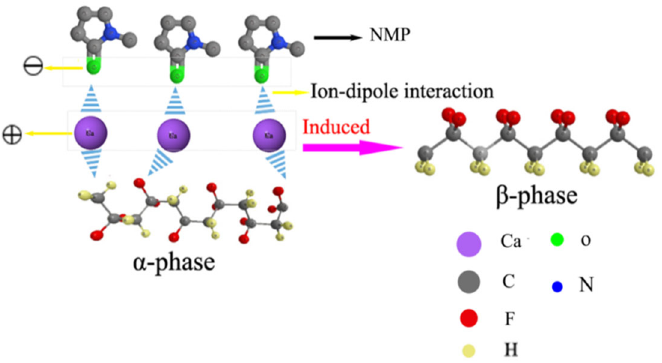
Figure 6. Mechanism of CaCl 2 promoting PVDF transition from the α‐ phase to β‐ phase.